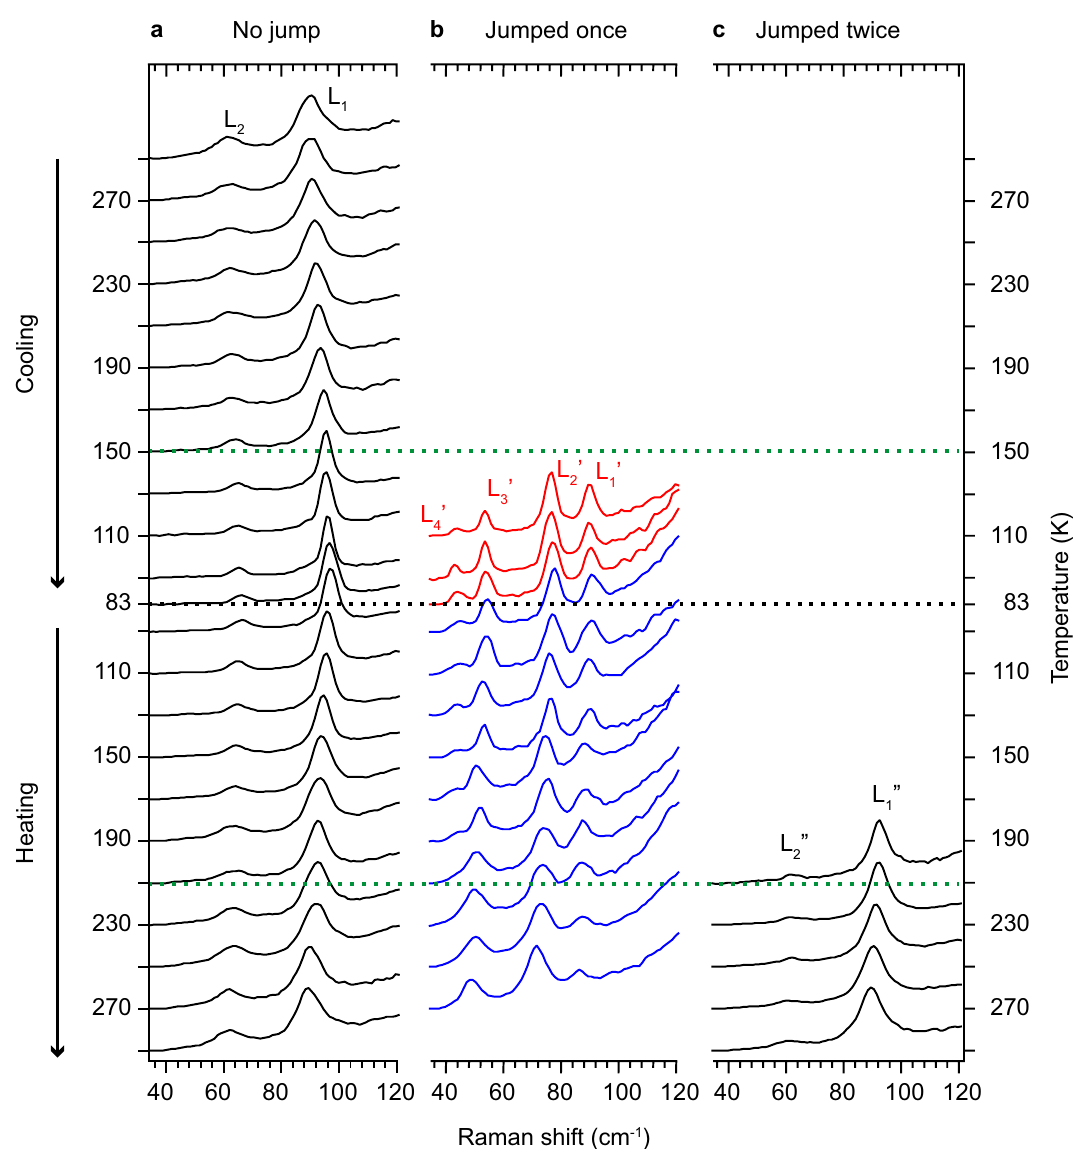
Figure 5. Raman spectra of single coronene nanofibers measured during the cooling/heating cycle of 300 → 83 → 300 K. ( a) Spectra of nanofibers that did not jump throughout the cooling/heating cycle. ( b) Red curves: Spectra of nanofibers that jumped during cooling measured immediately after landing on the substrate. Blue curves: spectra of nanofibers that jumped during cooling but did not jump during heating. ( c) Spectra of nanofibers that jumped during heating measured immediately after landing on the